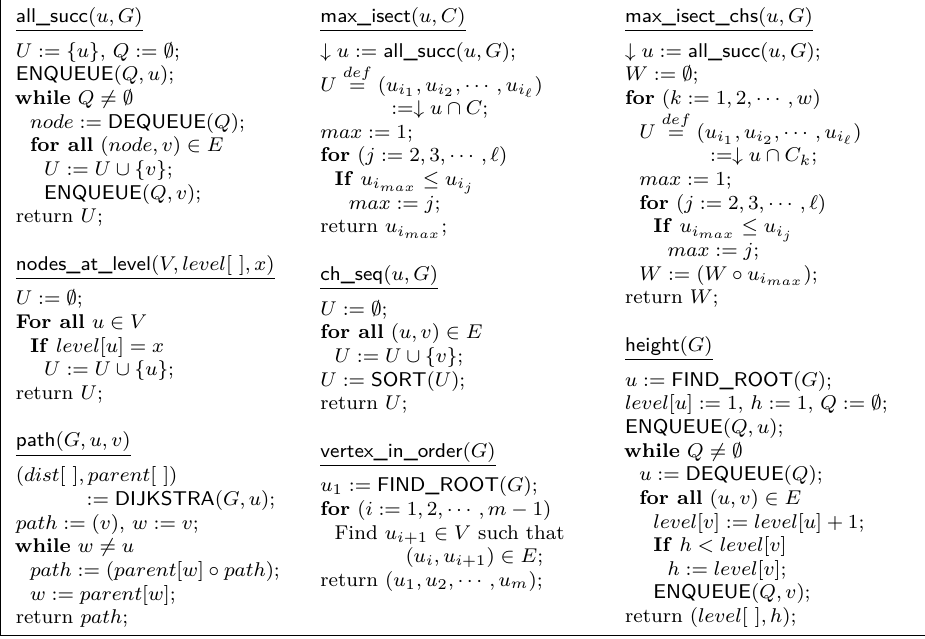
Figure 4: Graph algorithms used in the paper. Here: ENQUEUE ( Q, u ) operation appends the element u in the queue data structure Q ; DEQUEUE ( Q ) operation removes the first element from the queue Q , and returns the element; FIND_ROOT ( G ) function takes the graph G , and finds its root node (this node has no incoming edges); SORT ( U ) operation takes a list of elements, and returns a sorted list of elements based on their index values; and DIJKSTRA ( G, u ) is the Single-Source Shortest Path algorithm that takes the Graph G and source u as input, and gives the lengths of shortest paths (as dist [ ]) from u to all the nodes, and the parents of all nodes (as parent [ ])